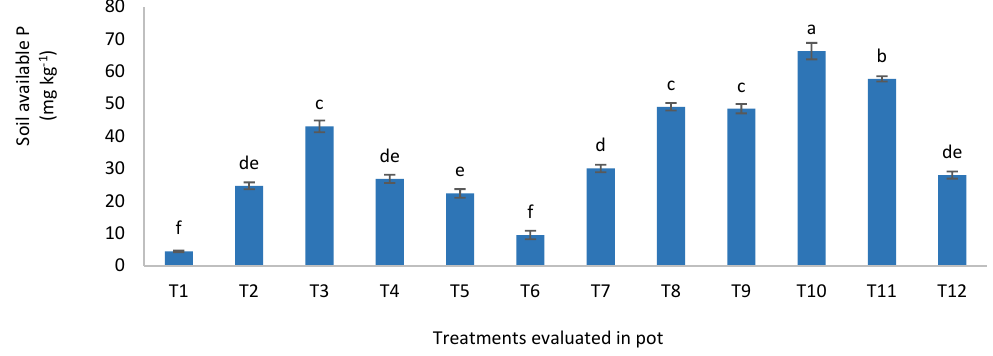
Figure 9. Effects of treatments on soil total phosphorus. Different letters indicate significant difference between means using Tukey’s HSD (Honestly Significant Difference) test at p ≤ 0.05. The error bars are the ± standard error of triplicates. Figure 11. Effects of treatments on soil soluble phosphorus. Different letters indicate significant difference between means using Tukey’s HSD (Honestly Significant Difference) test at p ≤ 0.05. The error bars are the ± standard error of triplicates. Soil total acidity, exchangeable Al 3+ , and H + of T1 were statistically higher than those of T2, T3, T4, T5, T6, T7, T8, T9, T10, T11, and T12 (Figures 12–14). In T2, soil total acidity and exchangeable Al 3+ were similar to those of T6 but higher than those of T3, T4, T5, T7, T8, T9, T10, T11, and T12 (Figures 12 and 13). Most tropical soils are acidic such that they are prone to Al toxicity. This results in low soil organic matter, high P fixation, and low microorganism activity [66]. Lower soil total acidity, exchangeable Al 3+ , and H + were observed in T3, T7, and T10 because these treatments had enough CLB to decrease soil total acidity and exchangeable Al 3+ (Figures 12–14). Furthermore, soil acidity reduces CEC and nutrient availability. Studies on tropical acid soils and plant productivity had suggested that soil and plant productivity relate to Al toxicity because this reduction leads to a significant increase in soil pH [67].